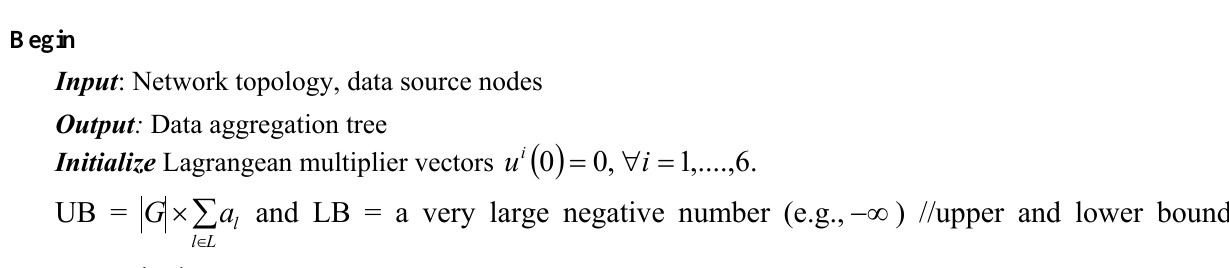
Algorithm 1: LGR Algorithm